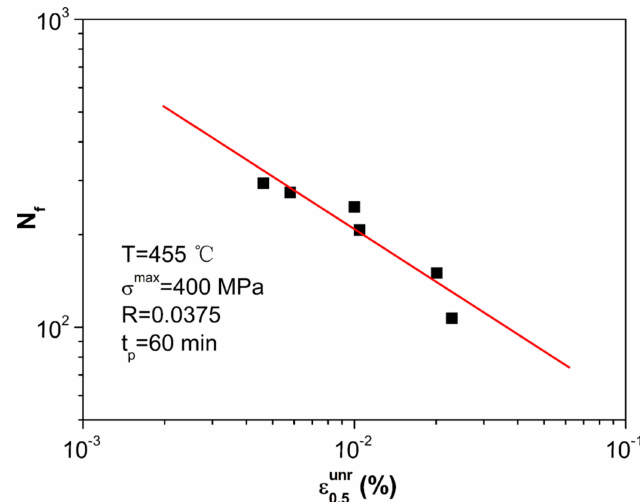
Figure 11. Liner fitting between unrecoverable strain of 0.5 N f and cycles to